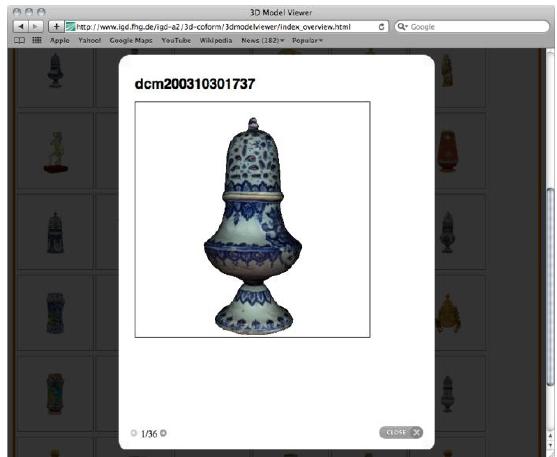
Figure 8. Coform3D – a line-up of multiple scanned 3D objects integrated with X3DOM and JavaScript into HTML.